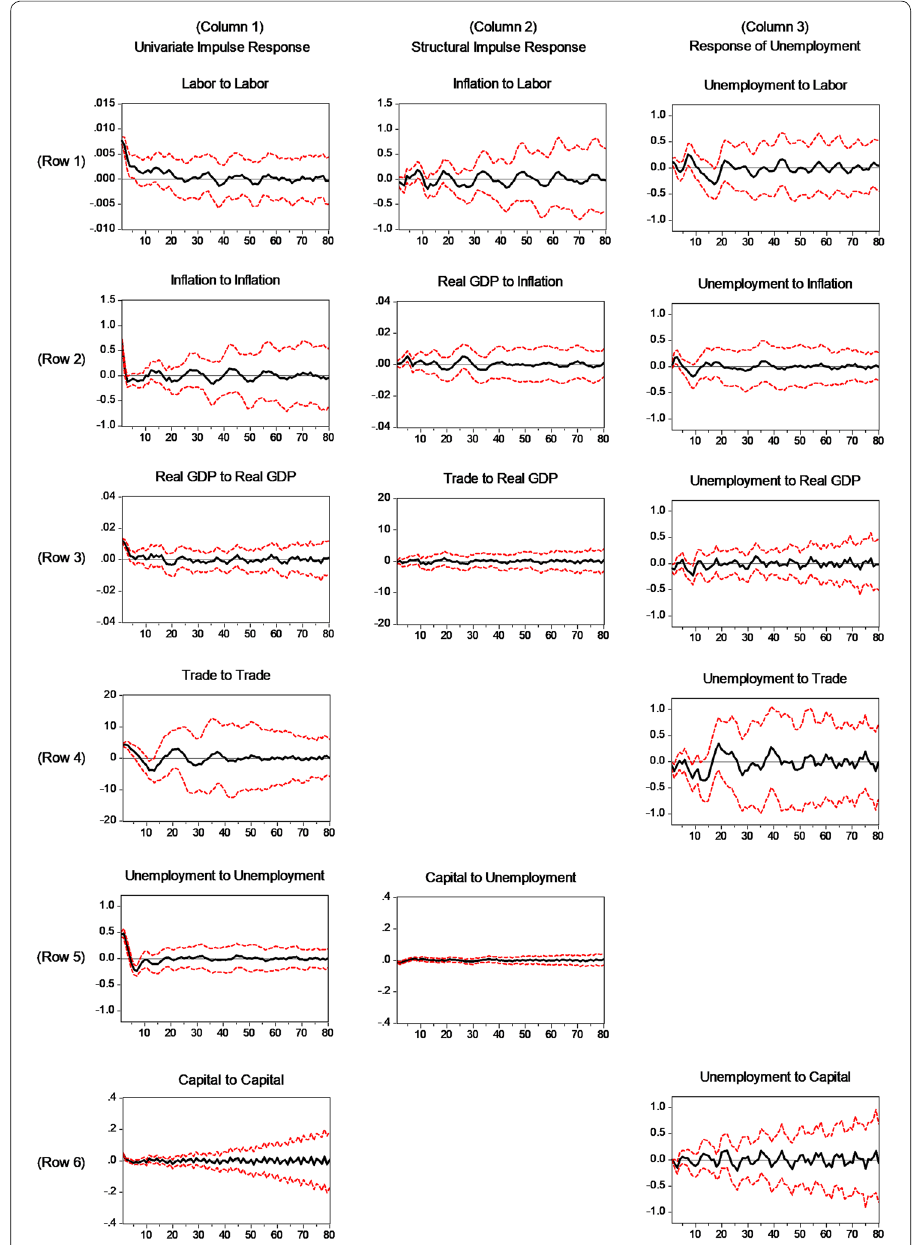
Fig. 5 Impulse response for 80 years: univariate, structural, and unemployment. The figure is developed using EViews (version 8) VAR and Cholesky decomposition method for impulse response. Each sub-figure shows the degree of response to one Cholesky standard-deviation shock ( the dash